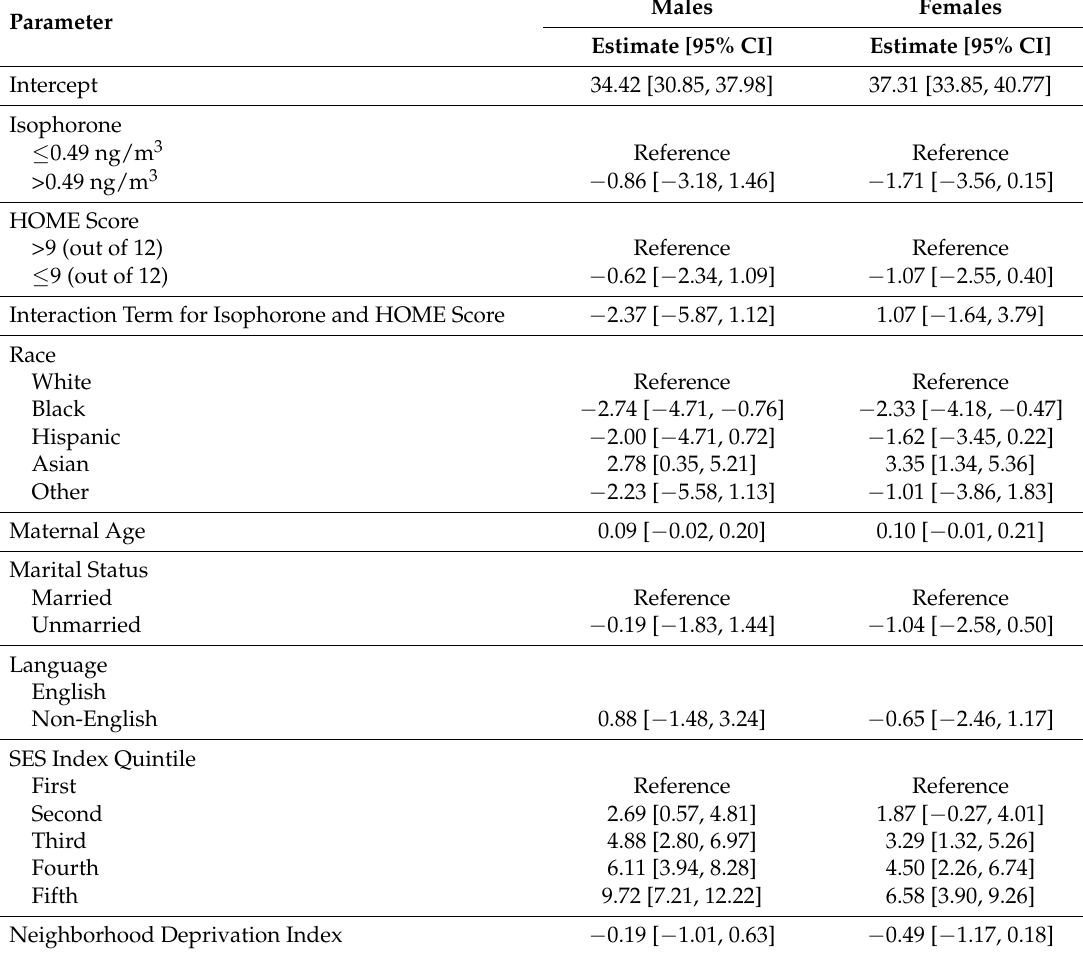
Table 5. Adjusted 1 parameter estimates for the association between high isophorone exposure, low HOME score, and math scale scores, stratified by child gender among the subset of the ECLS-B 2001 birth cohort living in urban communities (N =